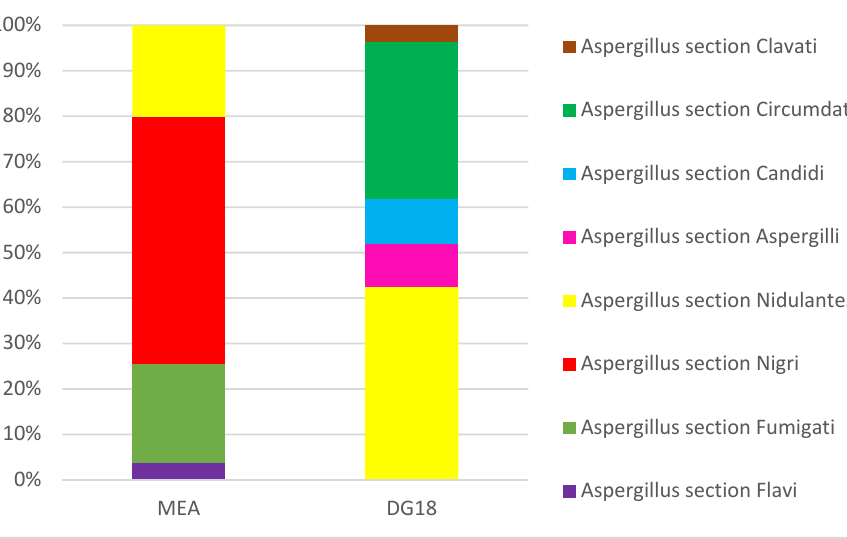
Figure 3. Aspergillus sections identified in EDC samples.